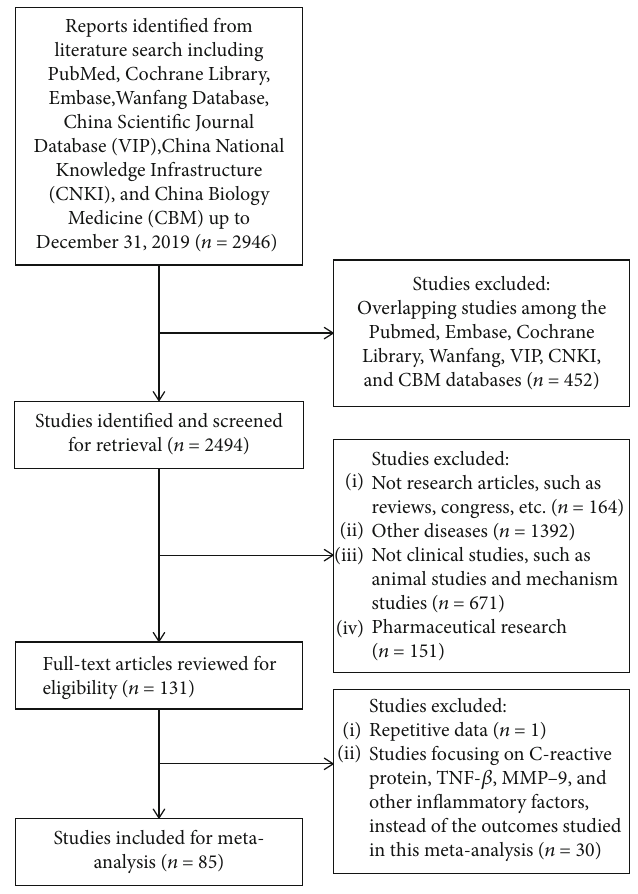
Figure 1: Flow diagram of studies included in this